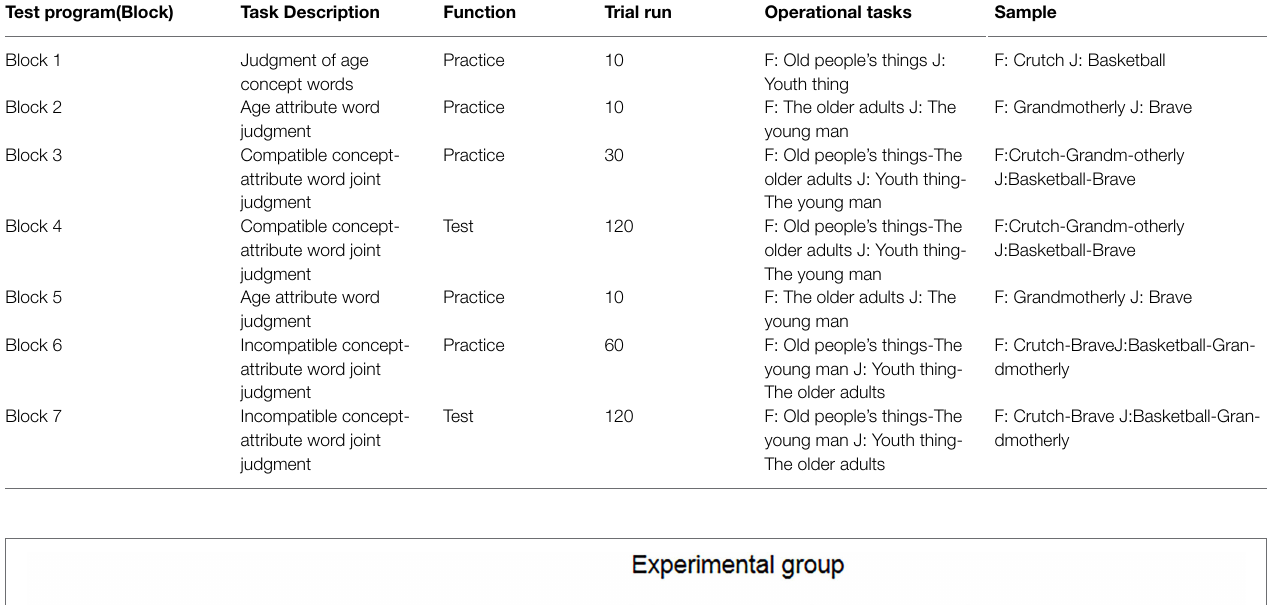
TABLE 1 | Flow chart of IAT test procedure.